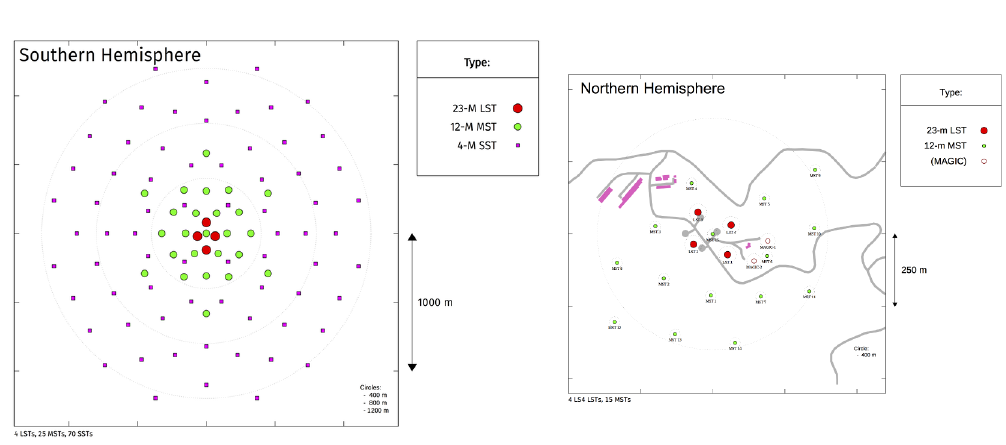
Figure 4. Left: Proposed layout for the three sizes of telescopes (LSTs, MSTs, and SSTs) in CTA-South (Paranal, Chile). Right: Proposed layout for the two sizes of telescopes (LSTs and MSTs) in CTA-North (La Palma, Spain). The roads are shown in grey and the buildings in purple. The current MAGIC telescopes are indicated by the open red